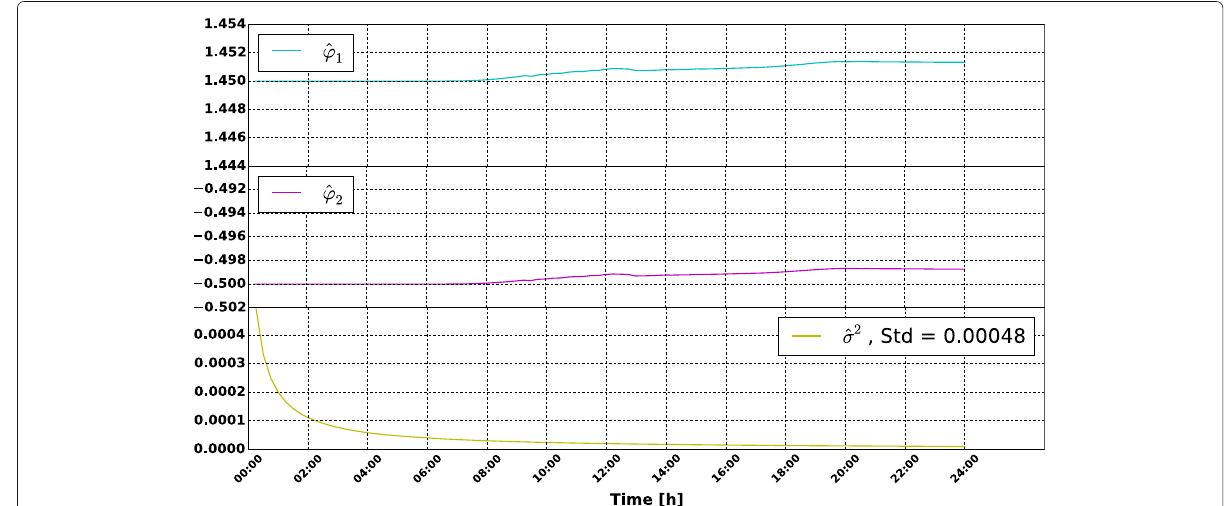
Fig. 4 Evolution of the online estimation of the ARMA coefficients ϕ and σ . Standard deviation for σ =0.00048